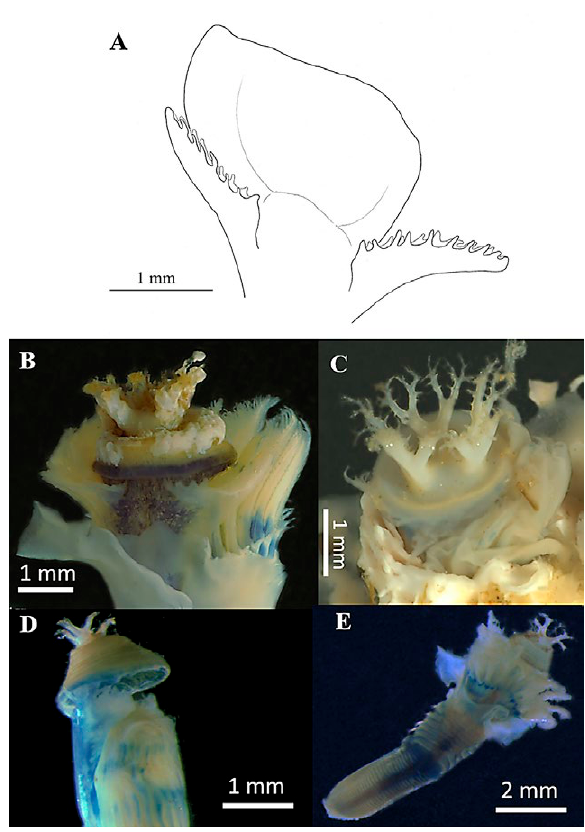
Fig. 5. – Spirobranchus cf. tetraceros from Valencia Port. A, oper- cular peduncle with distal wings (dorsal view); B-D, opercular mor- phology; D-E, ventral view of conical opercula with spines.